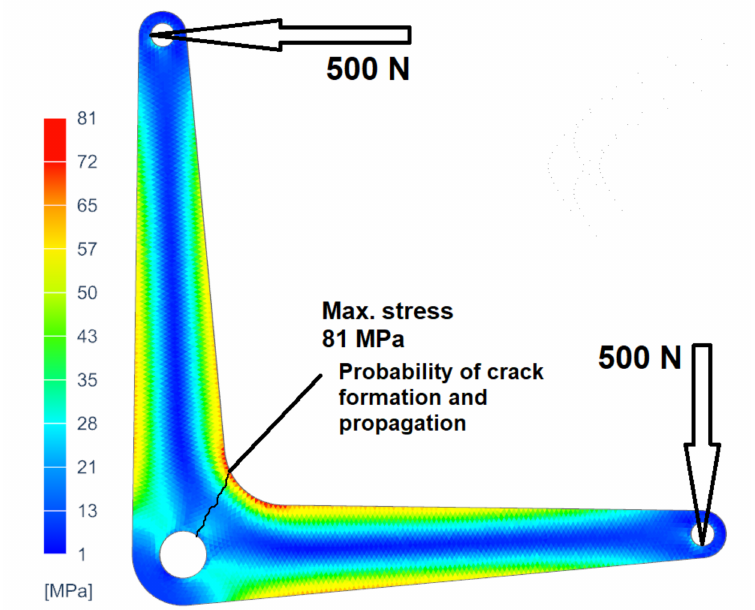
Figure 10. Result of the loaded lever simulation with the identification of the place of crack propaga- tion in a functional loaded part manufactured by the DMLS